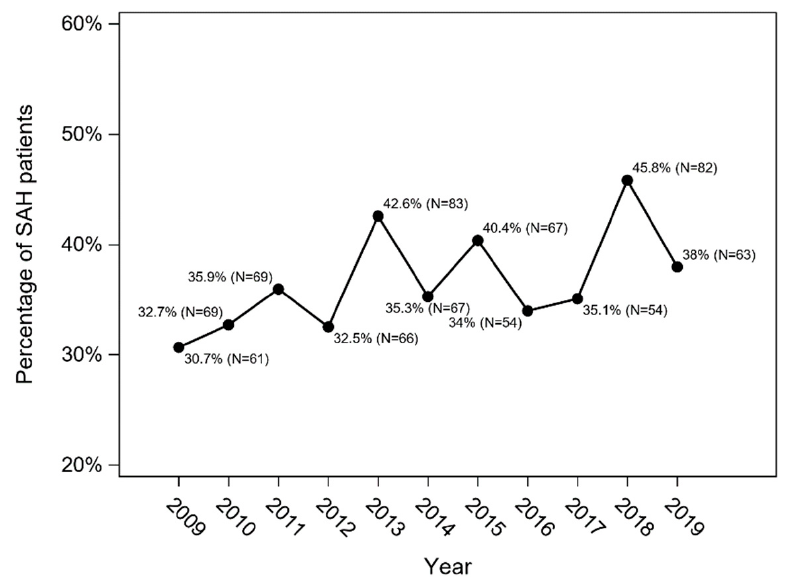
Figure 4. The overall in-hospital mortality in SAH patients in the Silesian Province between 2009 and 2019 (Cochran–Armitage trend test: p = 0.013).